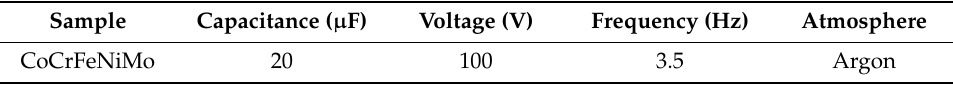
Table 2. Parameters used for CoCrFeNiMo electrospark